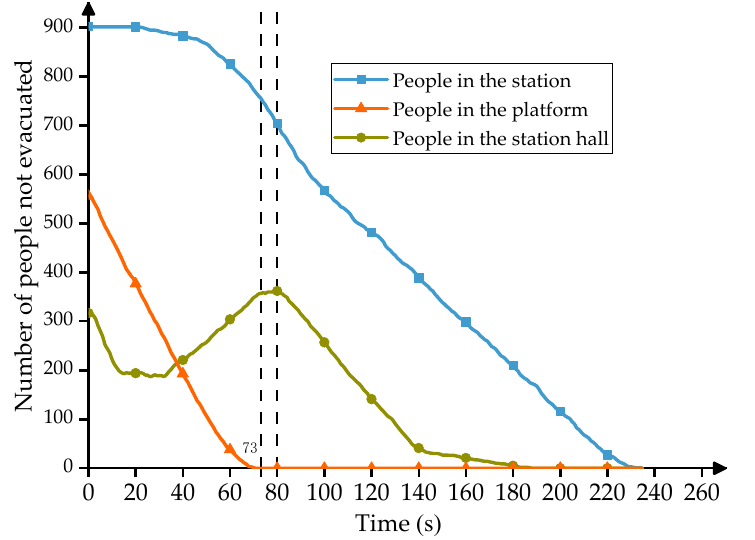
Figure 17. Comparative analysis of the number of people not evacuated from the fire in the middle of the platform.